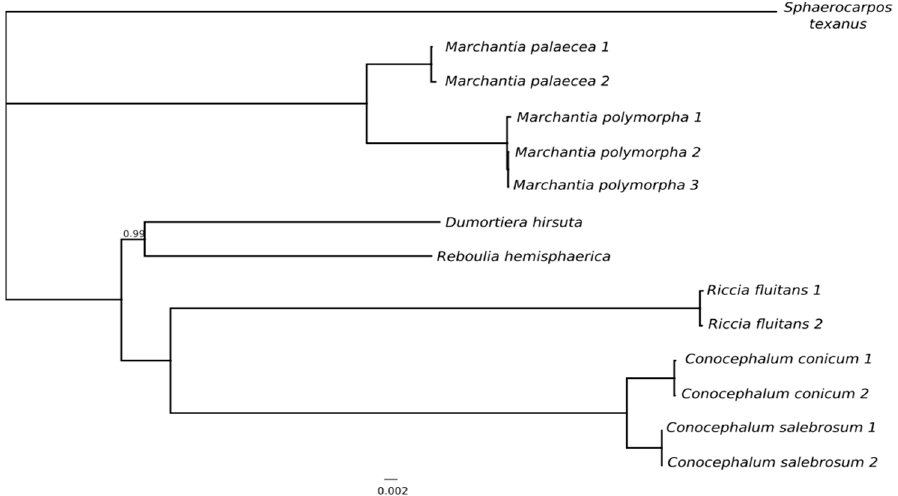
Figure 4. Phylogram of Marchantiidae derived from a Bayesian analysis of complete large single copy (LSC) and small single copy (SSC) regions. The posterior probabilities values lower than 1 are shown. The IR region was excluded from analysis due to incongruent phylogenetic signal.